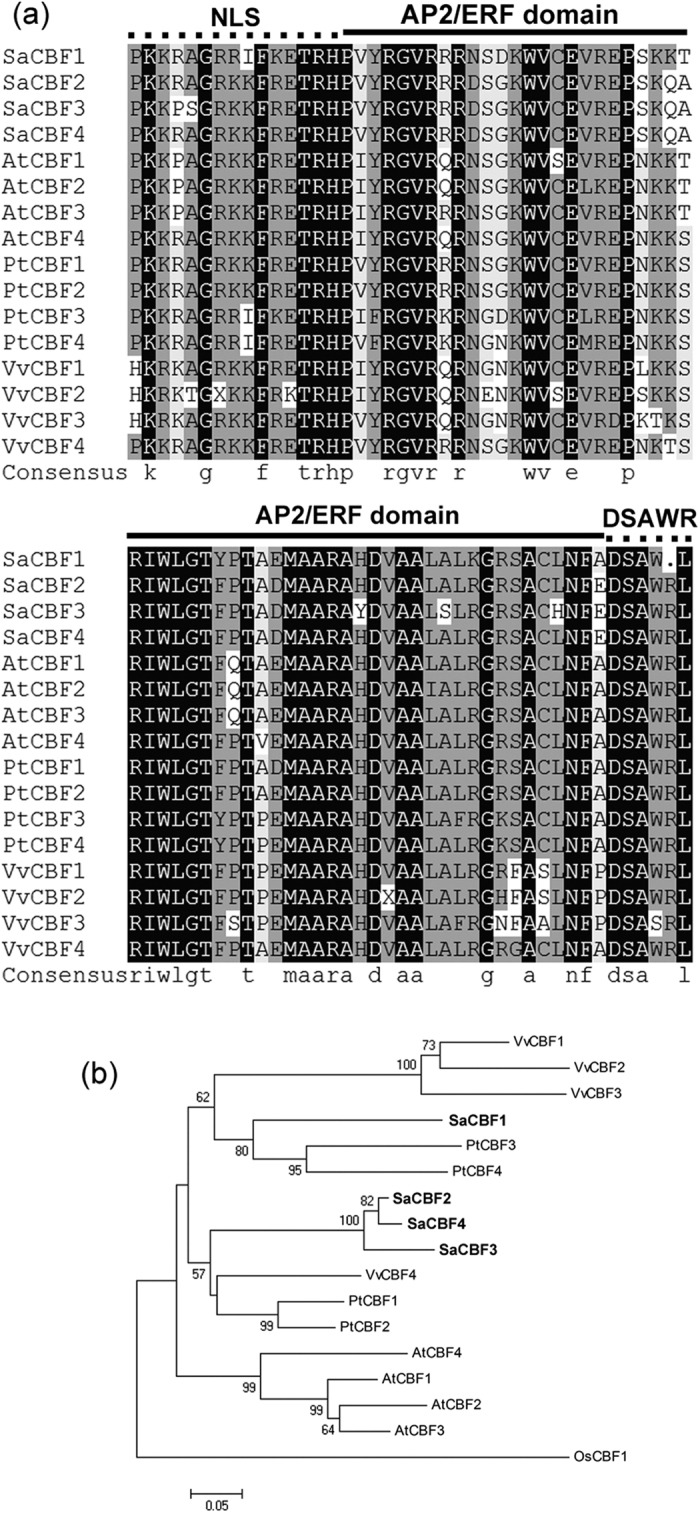
Comparison of representative C-repeat binding factor (CBF) protein family members in sandalwood, Arabidopsis (Arabidopsis thaliana (L.) Heynh.), poplar (Populus trichocarpa Torr. & A. Gray), and grape (Vitis vinifera L.).(a) Alignment of AP2 and flanking region of CBF factors. The AP2/ERF domain, putative nuclear localization signal (NLS), and DSAWR motif are marked with a solid line and a dotted line, respectively. (b) A phylogenetic analysis of sandalwood, Arabidopsis, poplar, and grape proteins, based on minimum evolution, was performed with the full-length protein sequences using OsCBF1 as an out-group. Sequences were aligned using four sandalwood CBF proteins: SaCBF1 (KX009414), SaCBF2 (KX009415), SaCBF3 (KX009416), and SaCBF4 (KX009417), four poplar CBF proteins, PtCBF1 (JGI666968), PtCBF2 (JGI346104), PtCBF3 (JGI548519), and PtCBF4 (JGI63608), four Arabidopsis CBF proteins, AtCBF1 (ABV27072.1), AtCBF2 (ABV27106.1), AtCBF3 (ABV27138.1), and AtCBF4 (ABV27155.1), and four grape CBF proteins, VvCBF1 (AIL00526.1), VvCBF2 (AIL00632.1), VvCBF3 (AIL00730.1), and VvCBF4 (AIL00786.1). CBF proteins were initially aligned using CLUSTALX (v1.83) and used to conduct phylogenetic analyses using MEGA version 4. A phylogenetic tree was constructed using the neighbor-joining method on 1,000 bootstrap replications. Bootstrap percentages are shown on the dendrogram branch points.